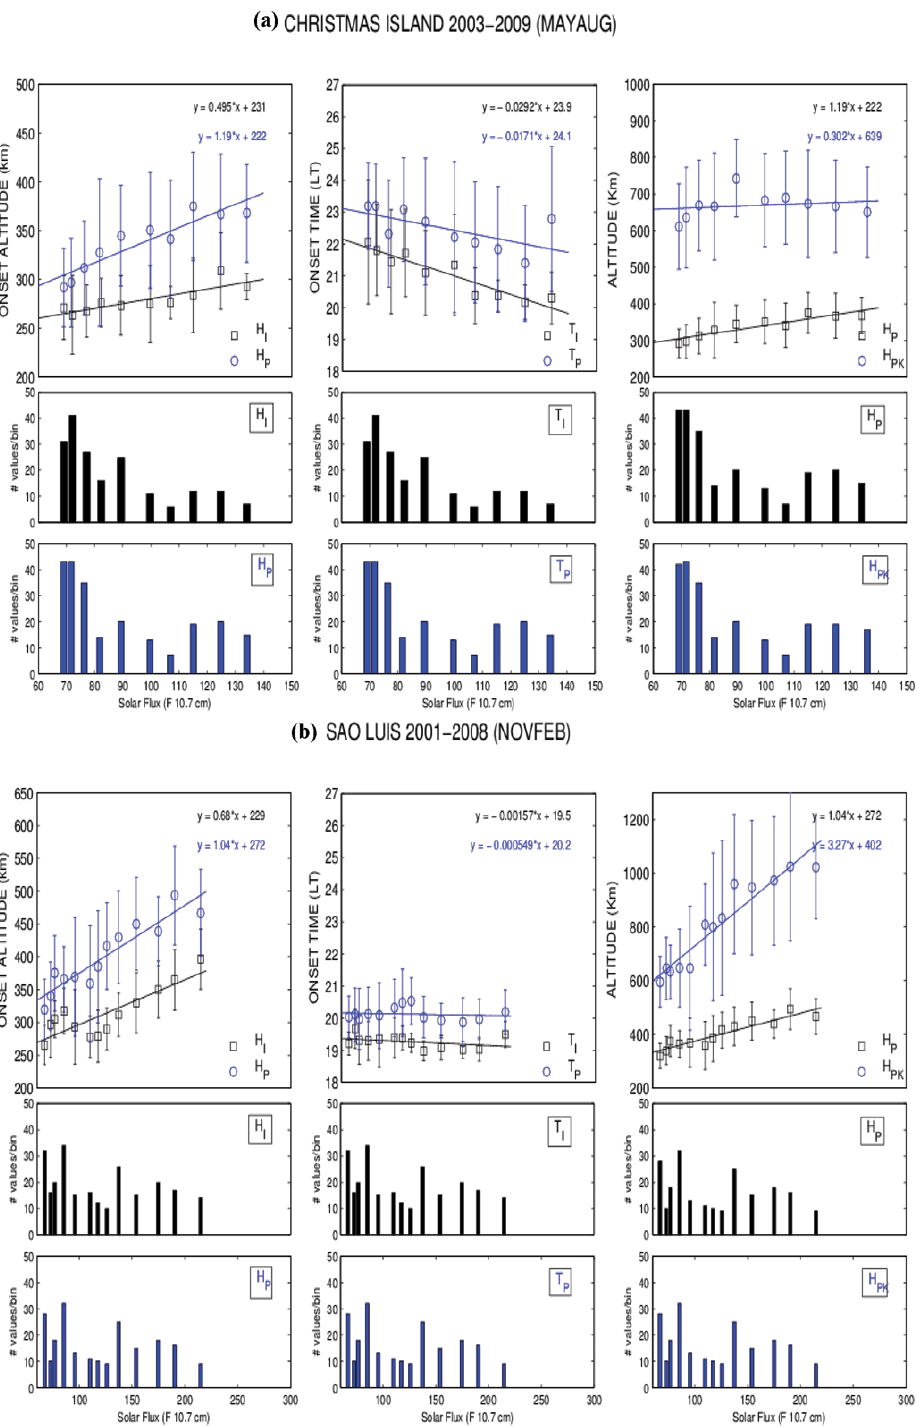
Fig. 4. VHF radar parameters for Christmas Island, São Luís and Jicamarca station, as a function of solar-flux. In the Fig. 4a–c, we depict the solar-flux dependence in the following format: in the upper panel from left-to-right columns, the ESF parameters ( H i , H p ), ( T i , T p ) and ( H p , H pk ) are plotted respectively. These values represent the 4 month average values and corresponding standard deviations are plotted as the error bars. In the middle-lower panels, the data-points that are used to estimate the average values in the corresponding upper panel, are